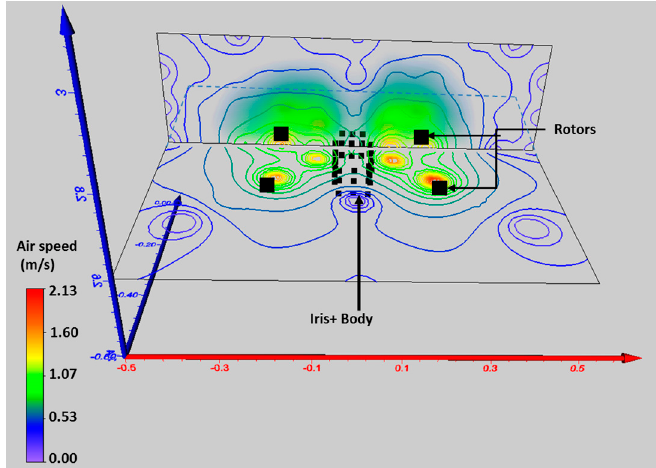
Figure 4. 3D visualization of the different airspeed regions produced by the propellers upwash at the top and sides of the multi-rotor UAV. Axis units in meters.